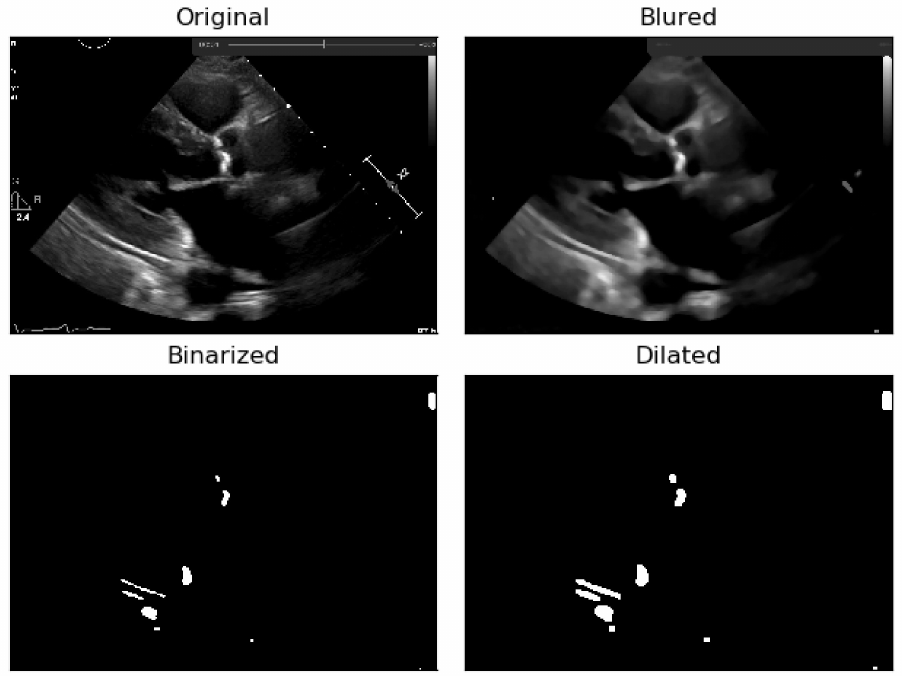
Figure 6. Application of the dilation mask to the regions of interest of the image, in order to recover the pixels lost in the blurring